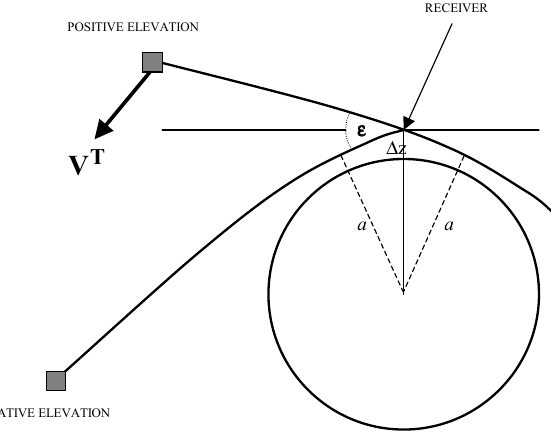
Fig. 2. Positive and negative elevation rays with the same impact parameter, measured by a receiver 1z above the Earth’s surface. (cid:15) is the angle between the ray paths at the receiver. Note that the relative scales of a and 1z are exaggerated for illustration